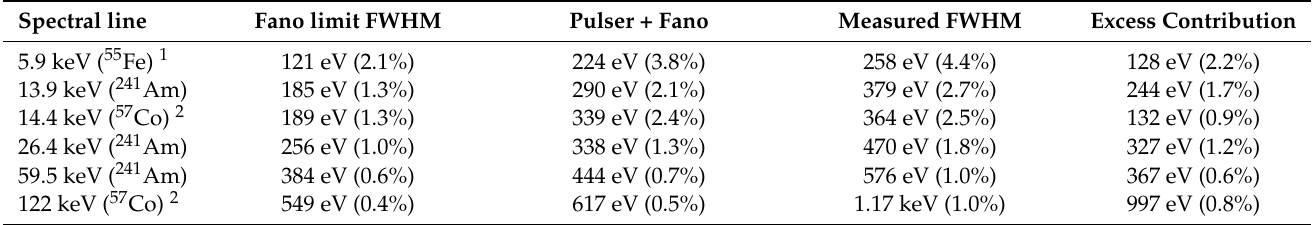
Table 1. Summary of measured FWHM in eV (energy resolution in %) and excess contributions, considering a Fano factor of 0.1 [33] and an electron-hole pair generation energy of 4.46 eV [41]. Measurements performed at 1 µs peaking time and +20 ◦ C, except where